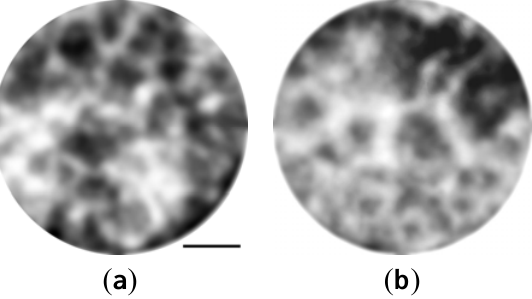
Figure 3. Typical LFIM images of Zr chemically induced field evaporation at a depth of about 100 nm. Scale bar is 10 nm.